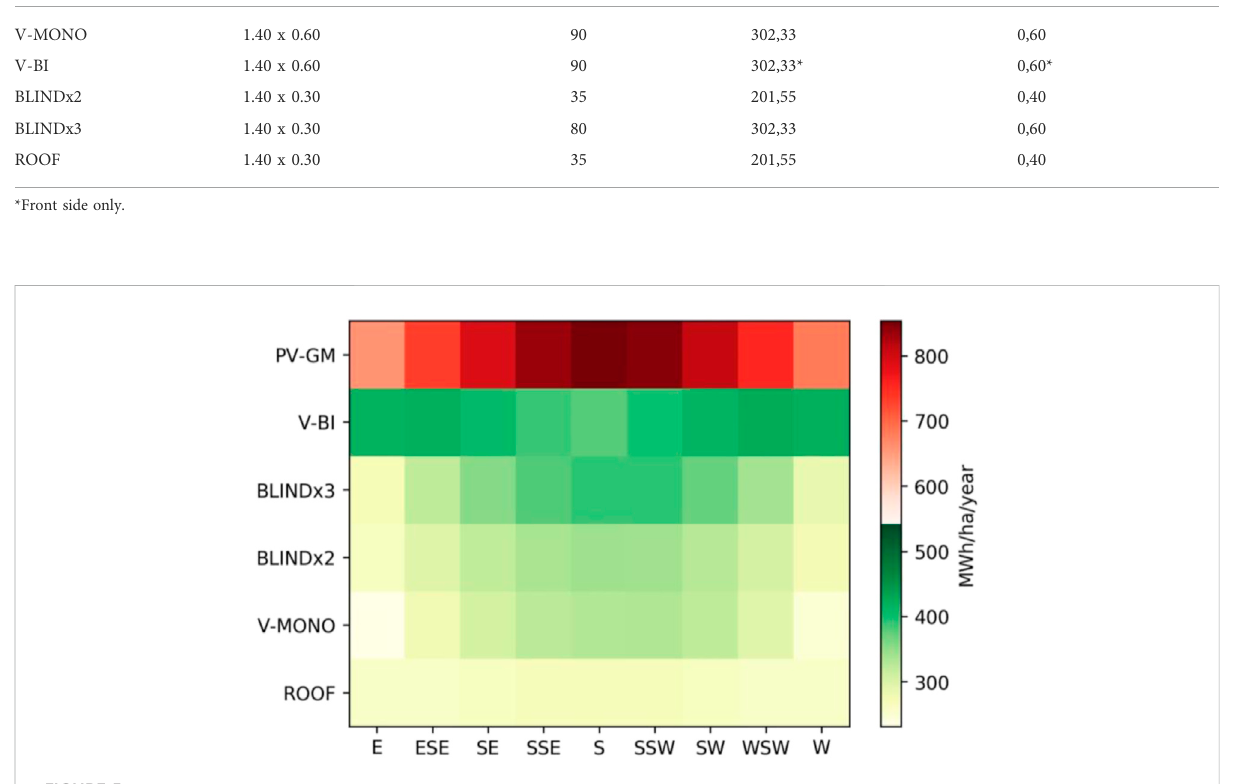
FIGURE 5 Annual energy generation per hectare for each con fi guration in different orientations (referring to the orientation of the PV module ’ s